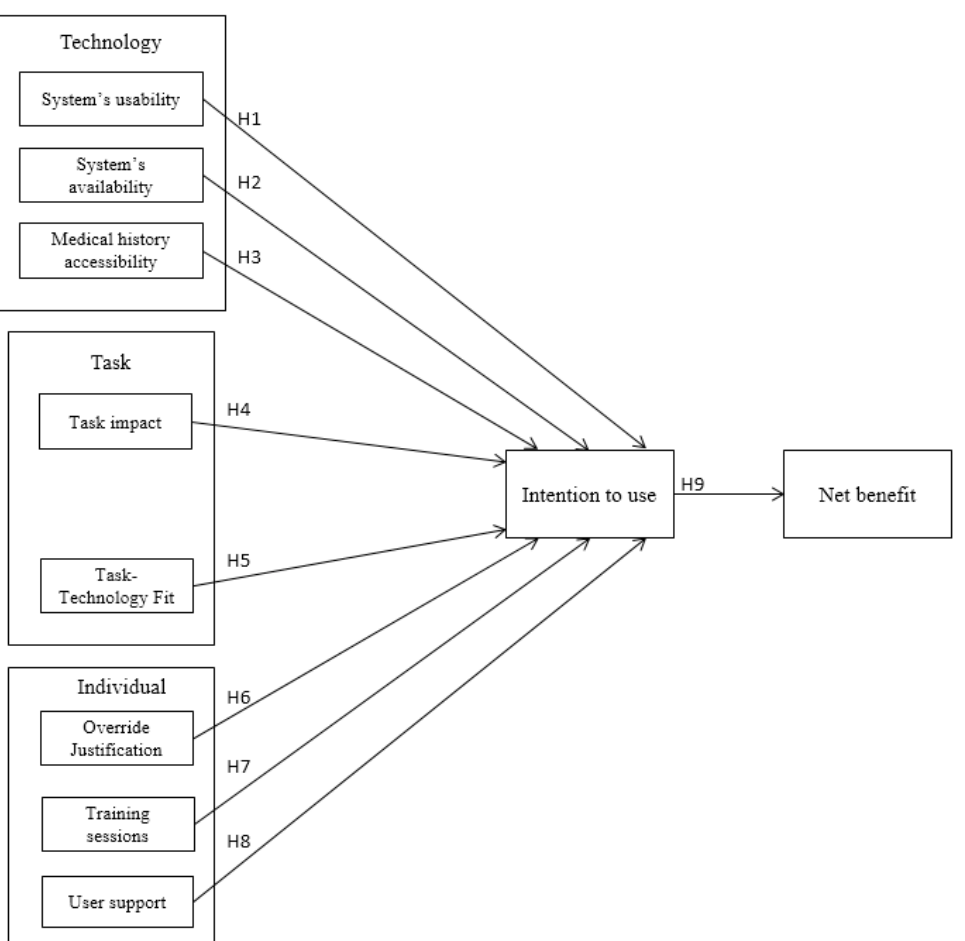
Figure 2. The research model with the hypotheses .